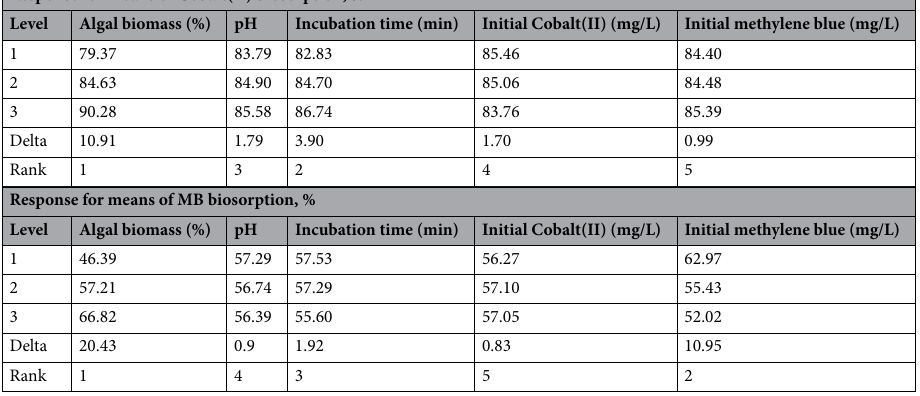
Response for means of Cobalt(II) biosorption,